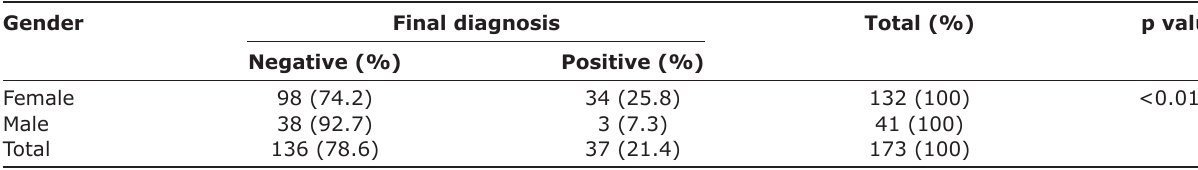
Table-5: Gender-wise prevalence of bovine tuberculosis in cattle in West Bengal.